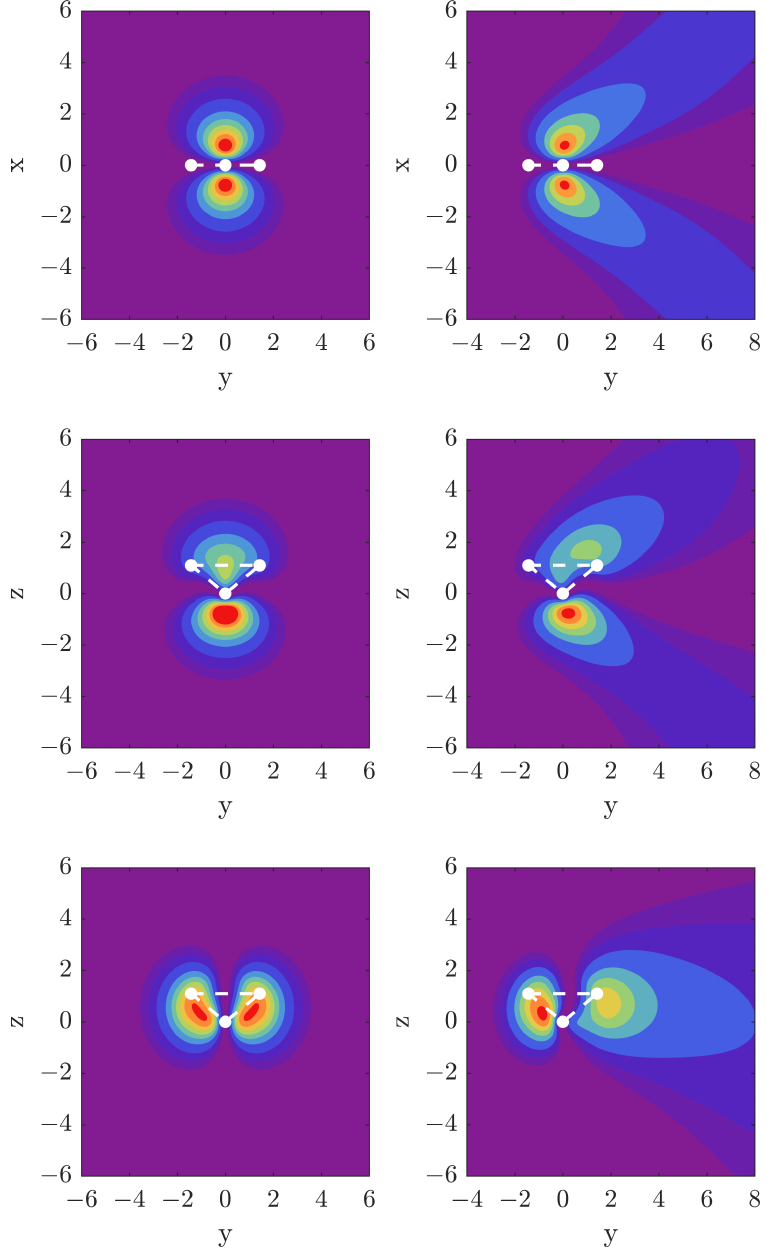
Figure 2. Probability densities of the MOs calculated at the level of (cid:96) max = 3 with a y -directed force: 1 b 1 ( top row ), 3 a 1 ( middle row ), and 1 b 2 ( bottom row ). On the left are the field-free cases, and on the right with electric force applied with strengths 0.20, 0.20, 0.16 a.u. respectively, which give similar decay rates. Contour heights starting with the outermost are 0.005, 0.01, 0.02, then they increase in steps of 0.02 a.u. The positions of the nuclei are marked by white